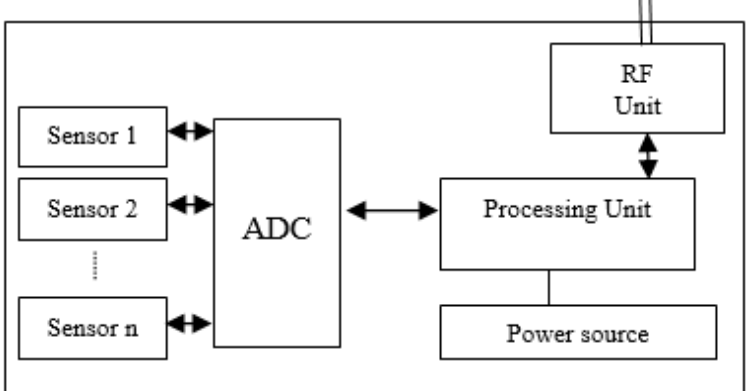
Figure 1. Block diagram of a simple Mote.